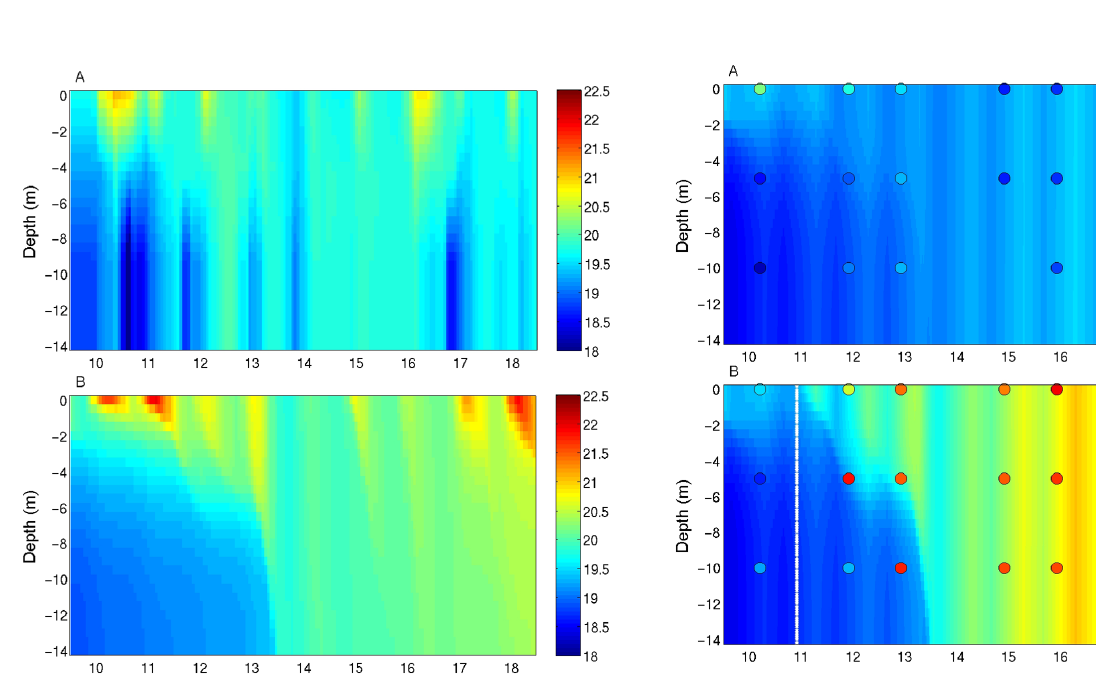
Fig. 3. Observed (A) and modelled (B) temperature ( ◦ C) during the DUNE experiment.